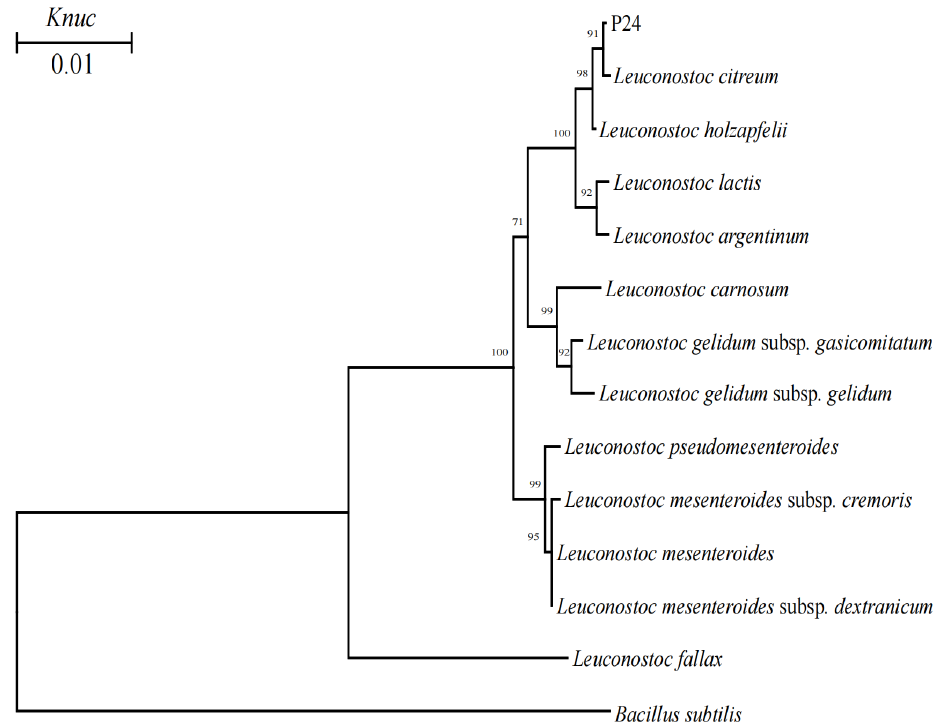
Figure 2. Phylogenetic tree showing the relative positions of cocci-shaped LAB strains isolated from pineapple residue silage by the neighbor-joining method of complete 16S rRNA sequences. Bootstrap values for 1000 replicates are shown at the nodes of the tree. Bacillus subtilis is used as an outgroup organism. The bar indicates 1% sequence divergence. Knuc = nucleotide substitution rate.